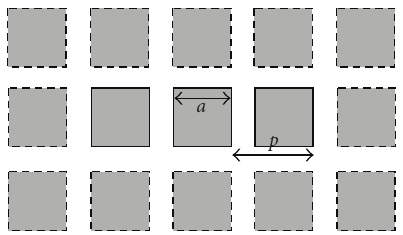
Figure 5: FSS composed of an array of square patche